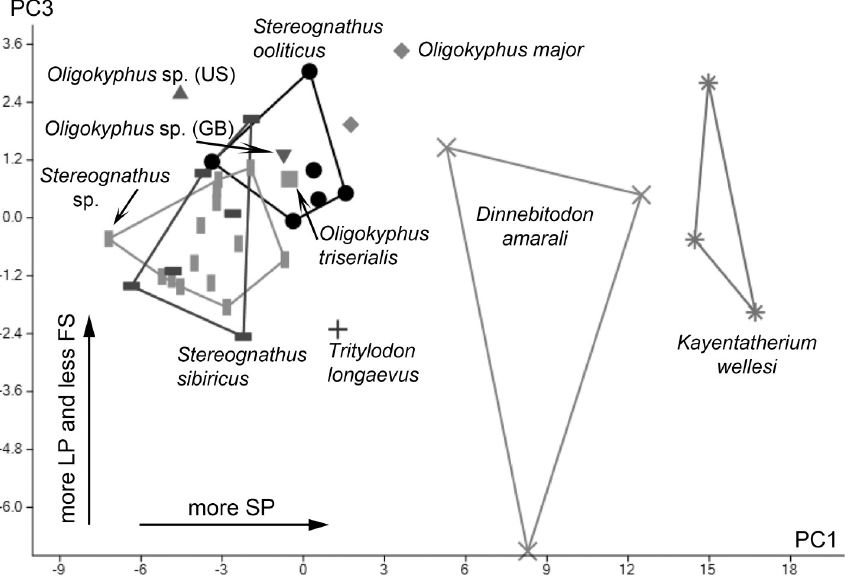
Fig 3. Scatter plot of principle components 1 and 3 on stereoscopic microwear parameters. Stereoscopic microwear parameters used are: number of small pits (SP); number of large pits (LP); number of fine scratches (FS); number of coarse scratches (CS). Convex hulls embrace areas taken by taxa with N > 2; symbols represent individual means.